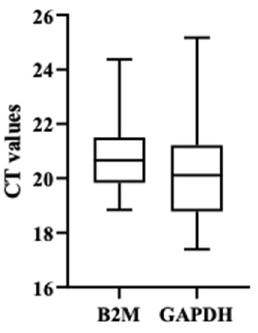
Figure 2. Box plot of CT values of B2M and GAPDH genes.